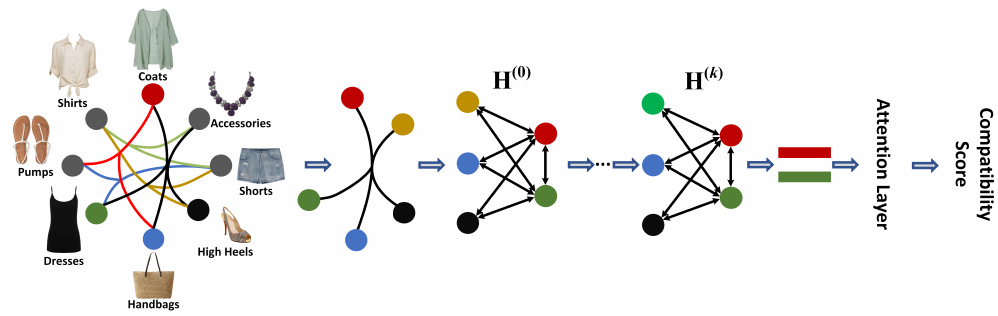
Figure 2. Overview of the proposed method. Based on the dataset, we first construct a fashion hypergraph, where an outfit (e.g., coats, short sleeves, handbags, high heels and skirts) can be represented as a hyperedge. We then design OCPHN to better model the node interactions in a hyperedge and refine the node representations. Finally, the compatibility score is calculated by the attention mechanism to predict the outfit